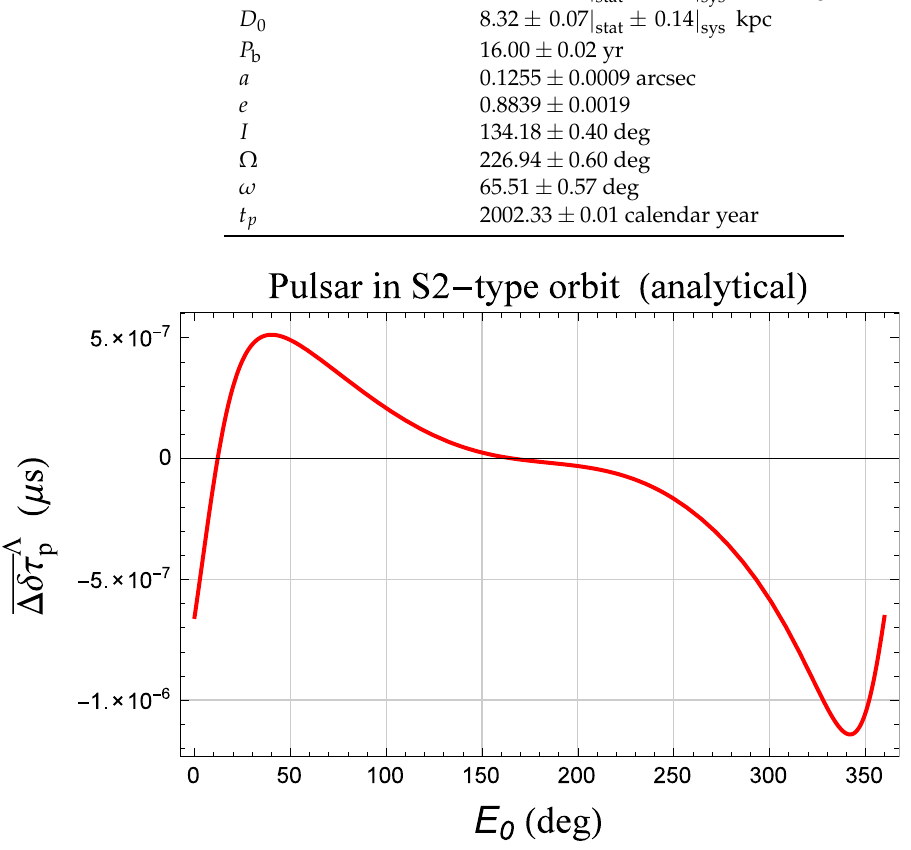
Λ µ s, of a hypothetical pulsar in Sgr A ∗ obtained Figure A1. Average orbital time shift per orbit ∆ δτ p , in analytically from Equation (27) along with the value of Equation (1) for Λ as a function of the initial phase E 0 . The orbital configuration of the S2 star, quoted in Table A1, was adopted. It can be noted Λ = 342.08 deg. that ∆ δτ p vanishes for two given values of E 0 ; the largest absolute value occurs for E 0 = 1 µ s, it translates to an upper bound on Λ of the order By assuming a pulsar timing accuracy of σ τ p of | Λ | ≤ 9 × 10 − 47 m − 2 ( (cid:46) 10 − 116 in Planck